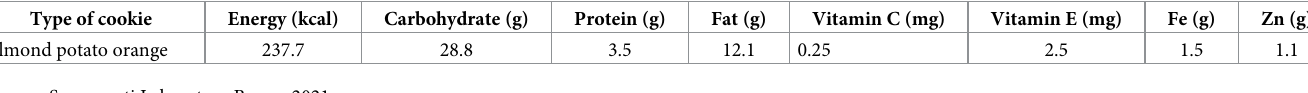
Table 1. Nutrient content per 50 g of almond potato orange cookie. Type of